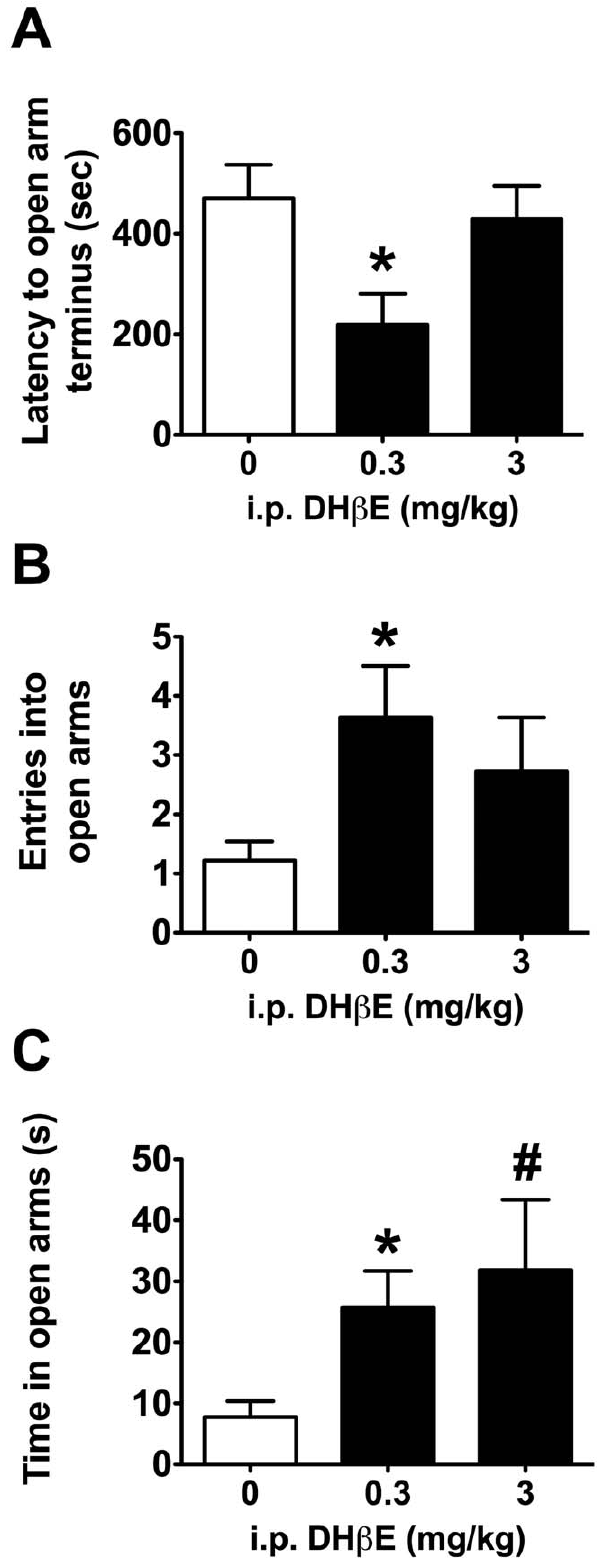
Figure 4. Antagonism of b 2*nAChRs promoted anxiolysis-like behavior in the elevated plus maze. A) Mice receiving 0.3 mg/kg i.p. DH b E required less time to explore the end terminus of the open arms of an elevated plus maze, B) made more entries into the open